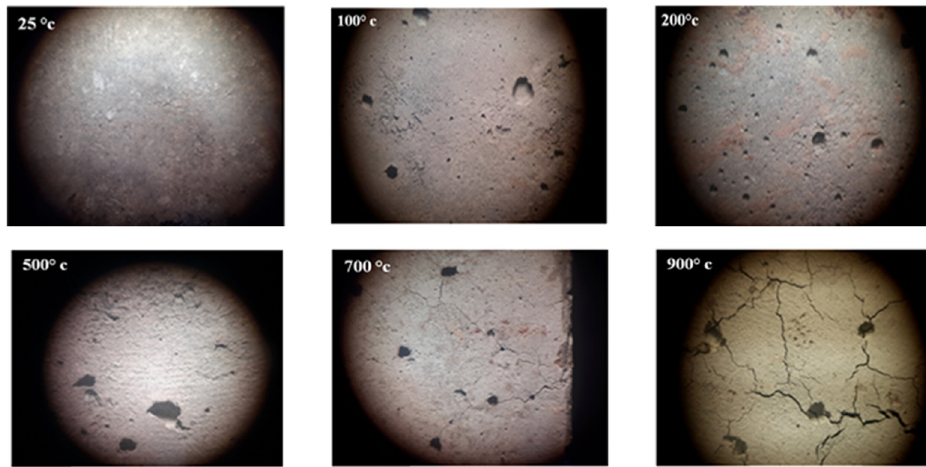
Figure 8: The apparent changes in concrete surface at high